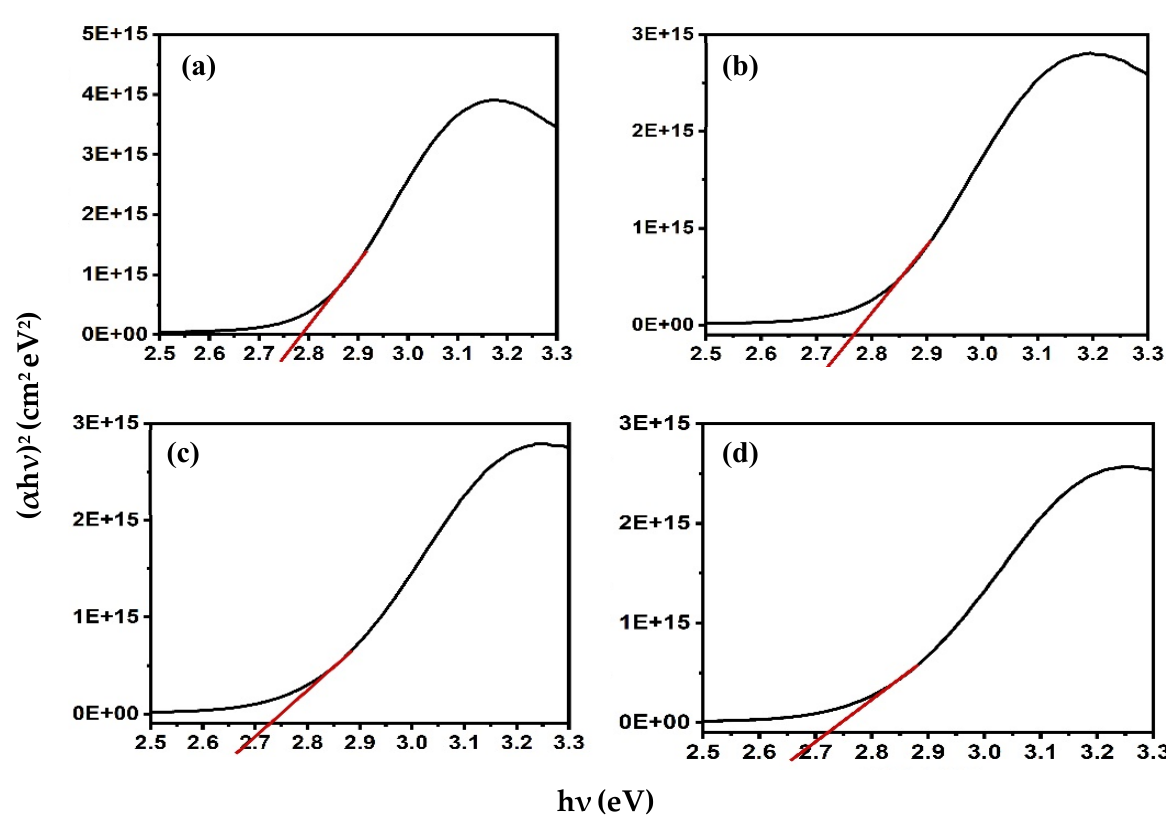
Figure 4. ( α h ν ) 2 versus h ν curves for ( a ) pure Alq3, ( b ) Alq3-10 wt.% ZnO QDs ( c ) Alq3-20 wt.% ZnO QDs ( d ) Alq3-30 wt.% ZnO QDs.